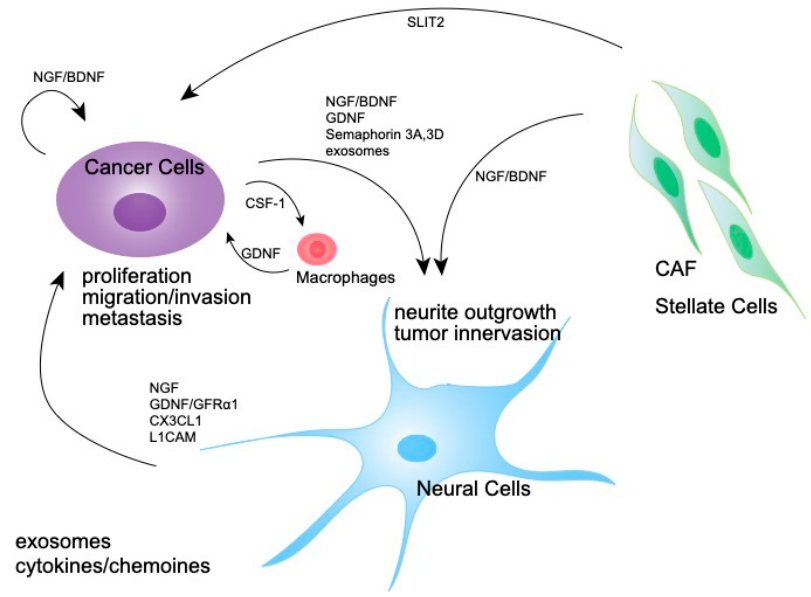
Figure 3. Molecular mechanism of the expansion of tumor-associated nerves. A schematic diagram showing the interaction of nerves, pancreatic cancer cells, and CAFs via neurotrophins and other molecules which induce nerve growth.